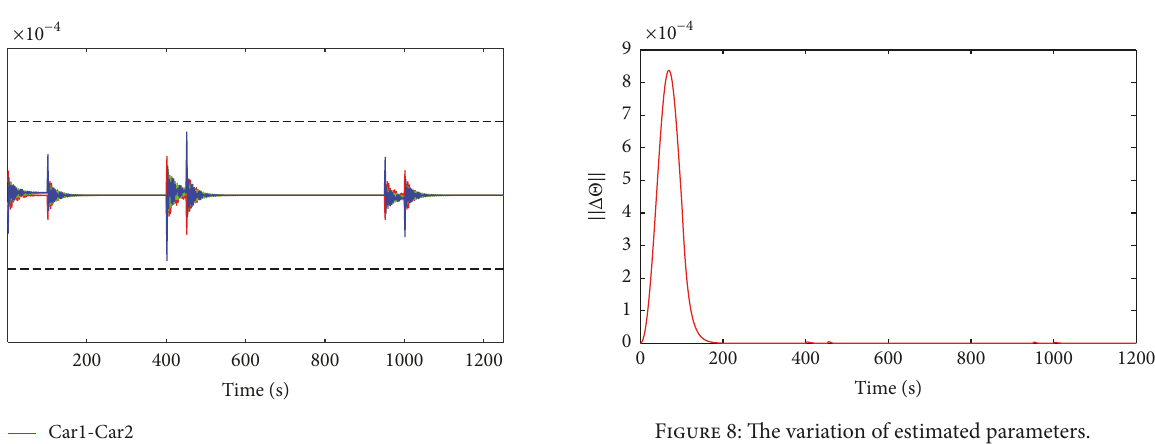
Figure 8: The variation of estimated